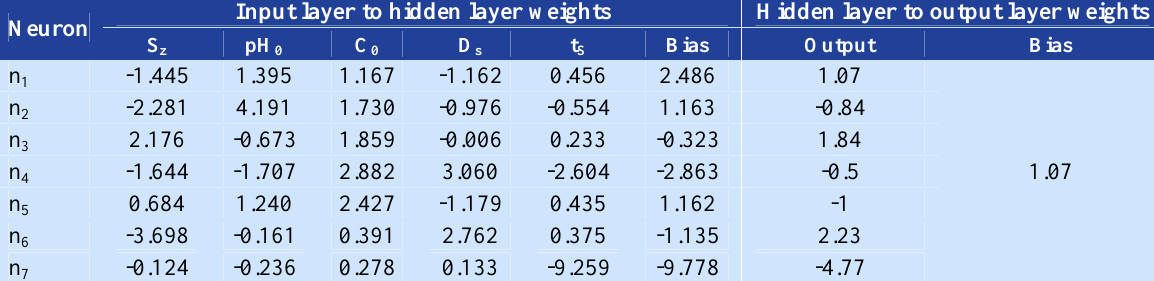
Table 3. Network weights and biases of the artificial neural networks (ANN) model Input layer to hidden layer Neuron